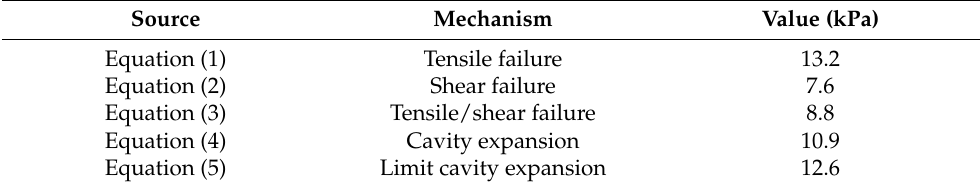
Table 6. Estimations on crack initial pressure of slurry soil.